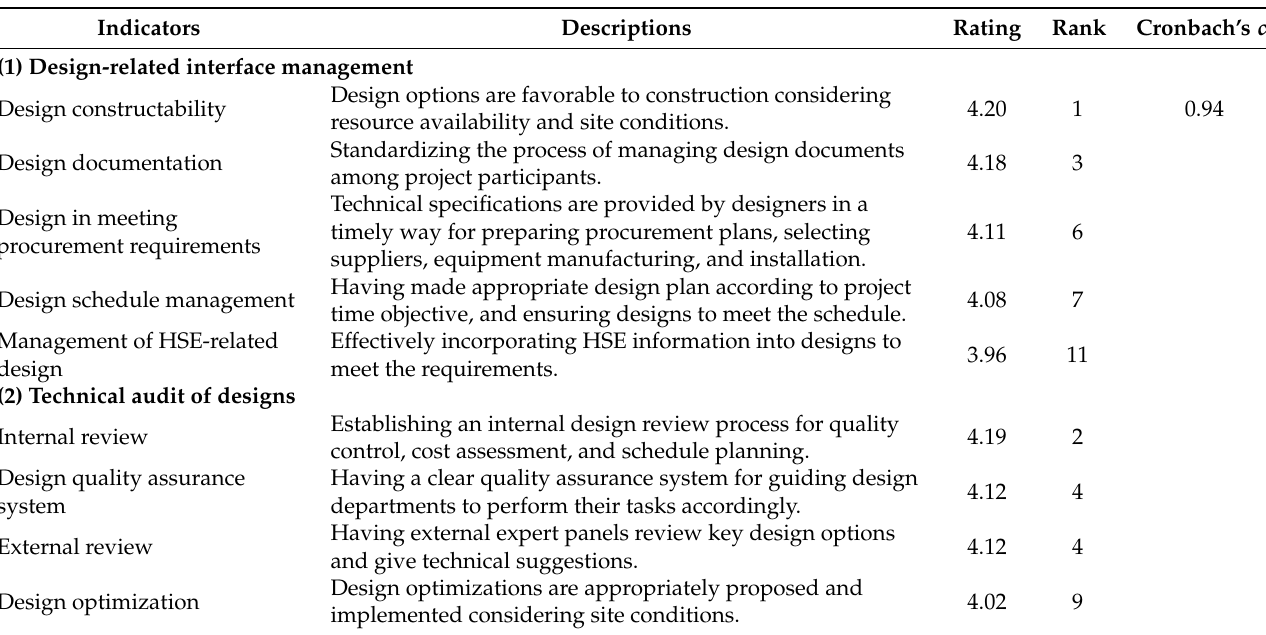
Table 3. Design management in the EPC